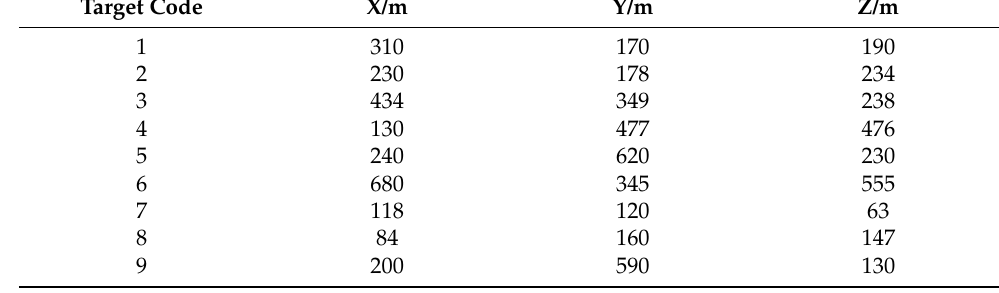
Figure 19. Curve fitting and MAD comparison.